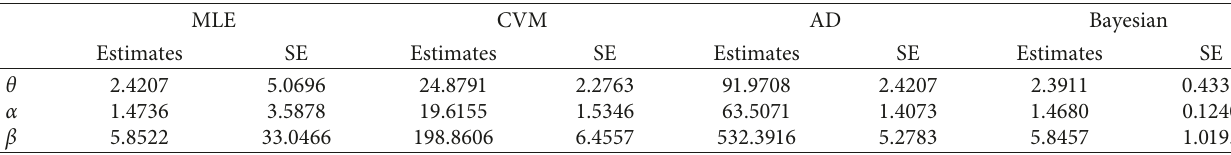
Figure 3: The cumulative function and empirical CDF, histogram, and P–P plot for MKKu distribution for COVID-19 data of Saudi Arabia. Table 4: Estimators by using different estimation